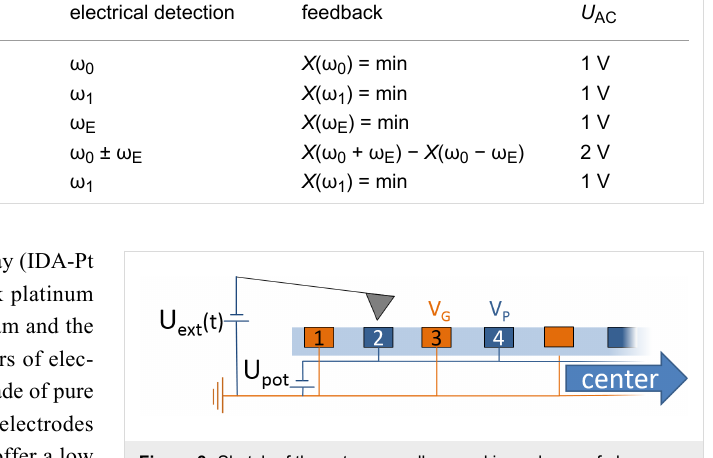
Figure 3: Sketch of the setup as well as marking scheme of elec- trodes on the edge. U ext represents the electrical excitation applied to the cantilever, U pot the potential applied to the electrodes.